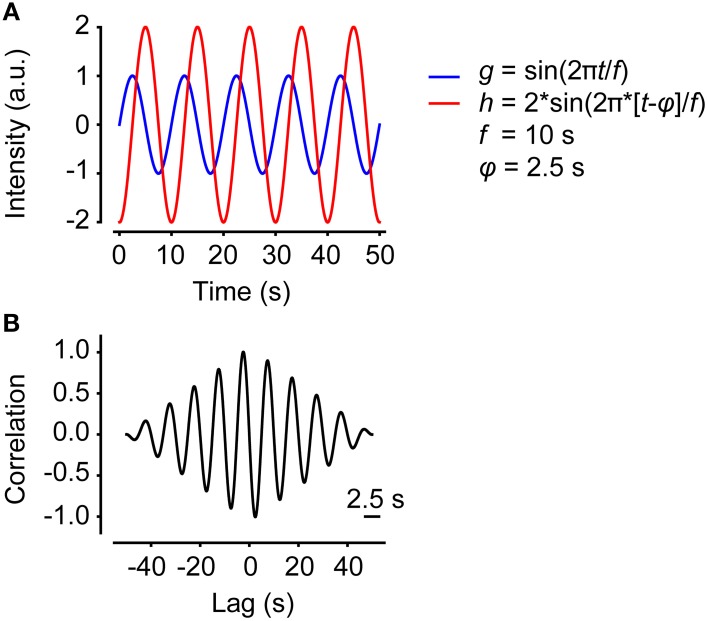
Correlation as a function of lag. (A) Two sine functions with the same frequency but different amplitudes and phases, plotted in the same graph. (B) The correlation as a function of lag of the two sine waves in (A).